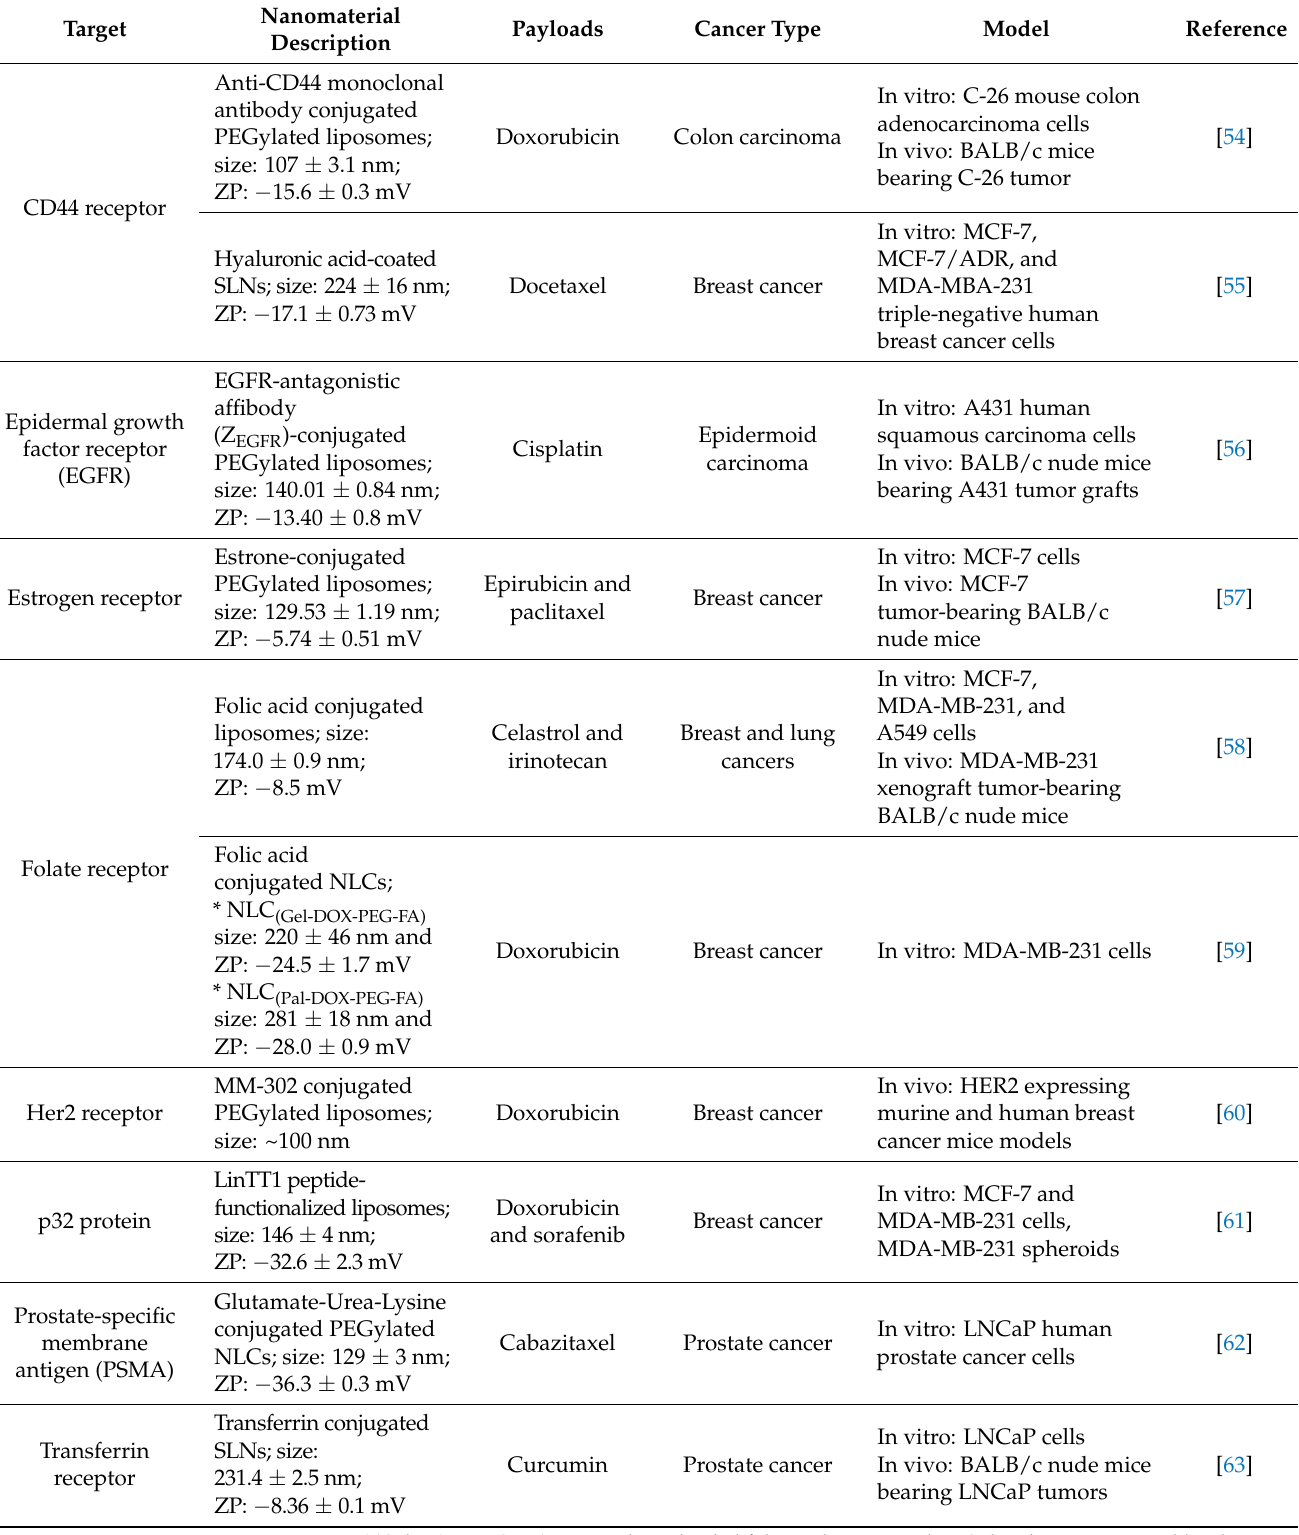
Table 1. Surface-functionalized lipid-based nanocarriers for active tumor